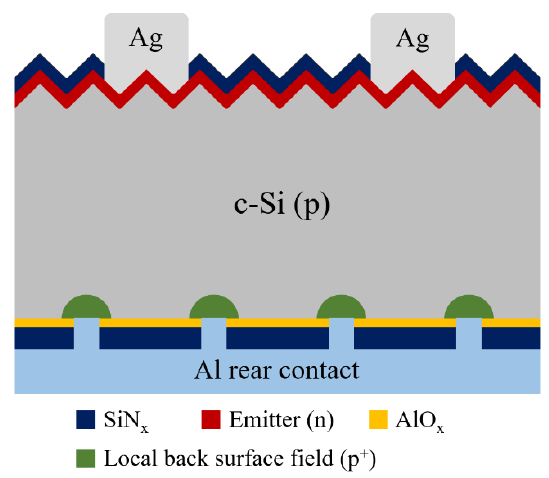
Figure 3. Schematic of the industrial PERC solar cell structure.